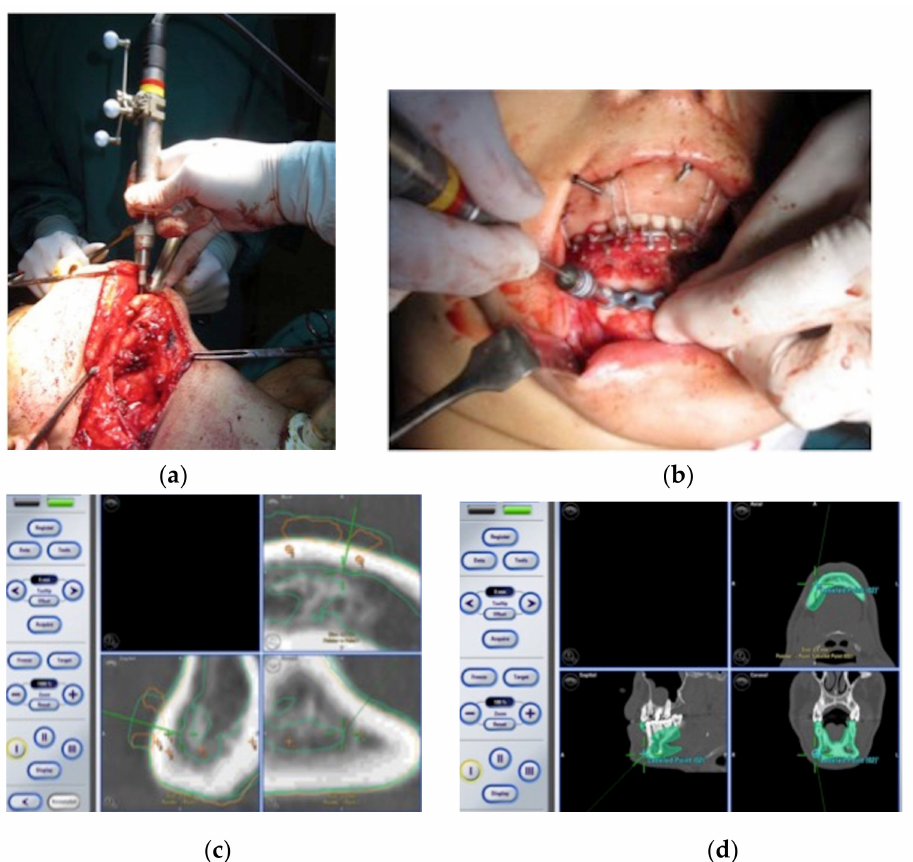
Figure 5. ( a – d ): The fibula flap is inset and fixed through a recorded drill and surgical